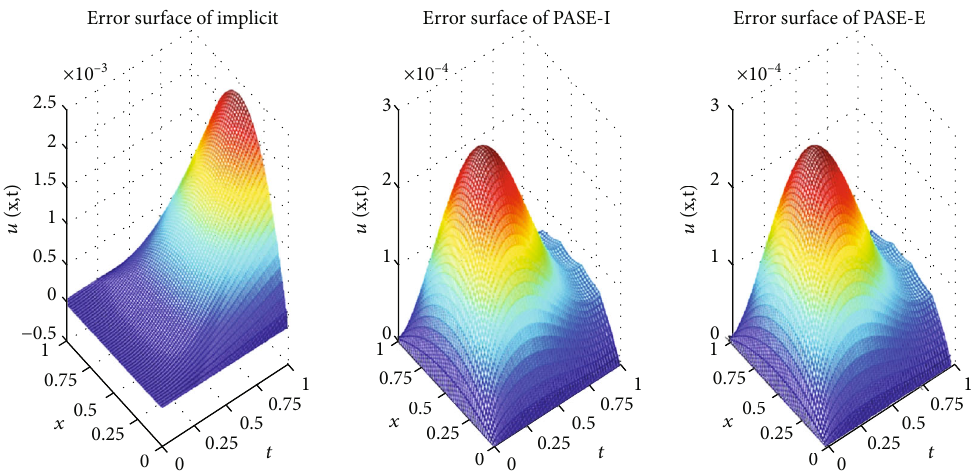
Figure 3: The error surface of numerical